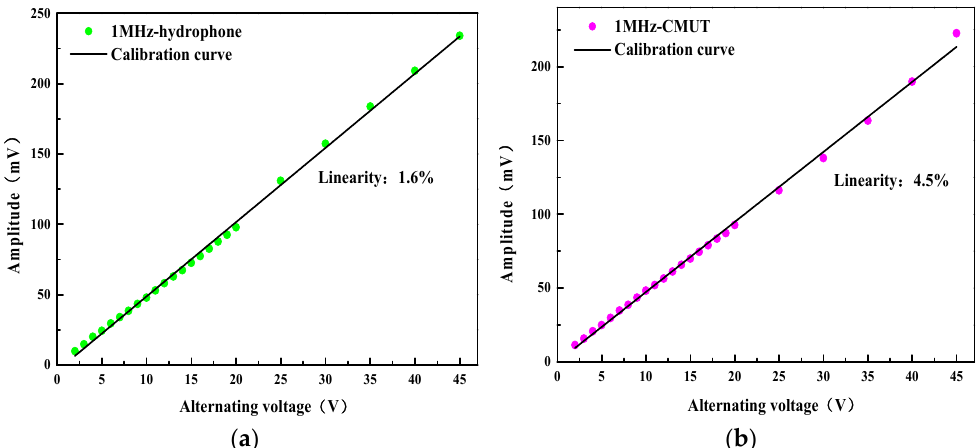
Figure 18. ( a ) Receiving linearity of the hydrophone; ( b ) Receiving linearity of the CMUT with coat- ing.